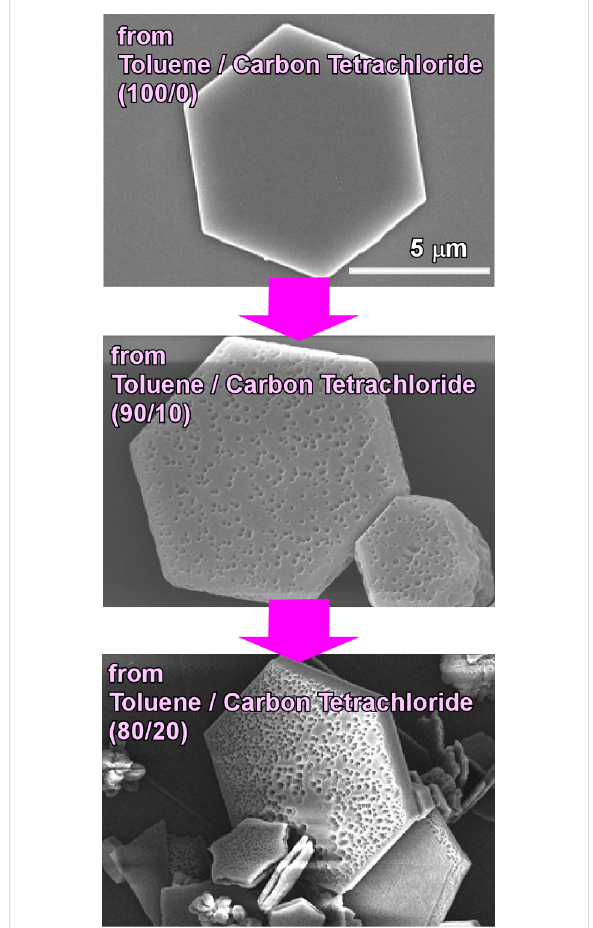
Figure 18: Two-dimensional C 60 hexagonal nanosheets with hierar- chic pore systems of macropores and mesopores prepared by liquid–liquid interfacial precipitation from isopropyl alcohol and mix- tures of benzene and carbon tetrachloride. The porosity can be tuned through the mixing ratio between benzene and carbon tetrachloride. SEM images were reproduced with permission from [68], copyright 2019 The Royal Society of